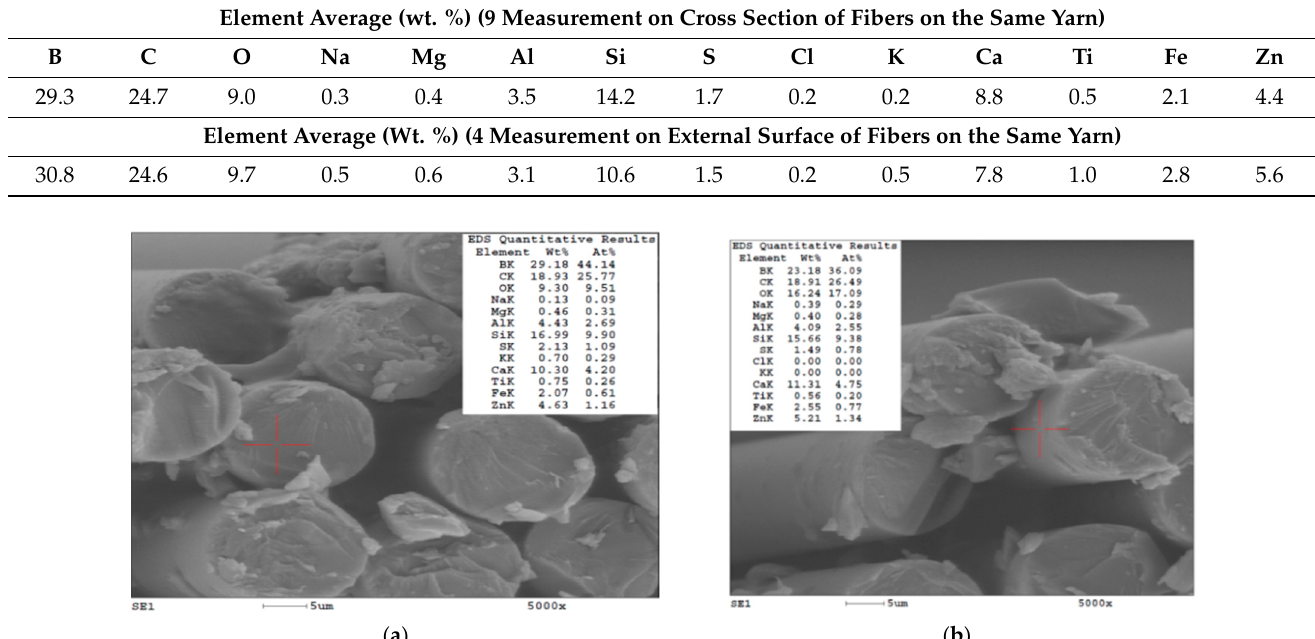
Table 3. Characteristics of resin Biresin ® CR82 and hardener Biresin ® CH80-2 [39].